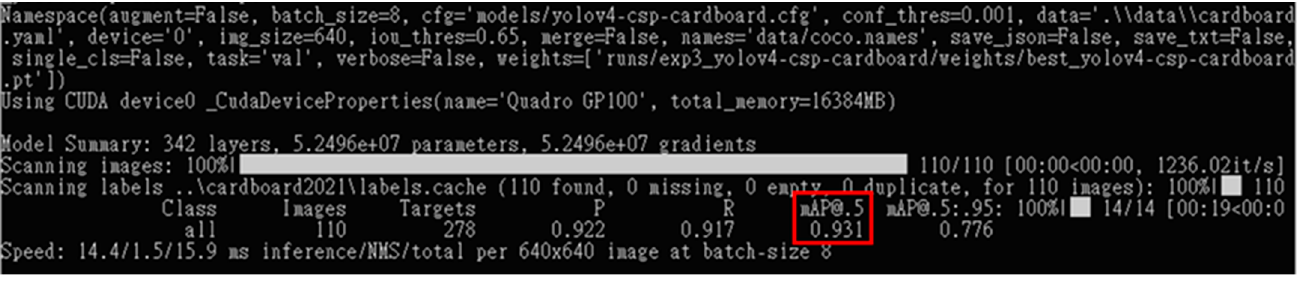
Figure 12. Test of a trained model.